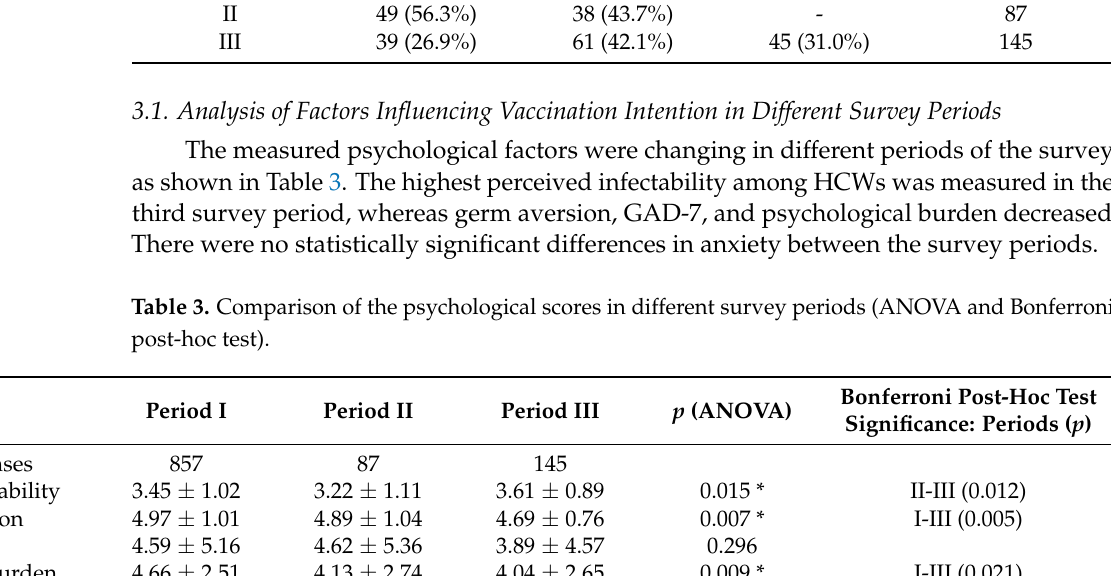
Table 2. Vaccination intention and vaccination status of the respondents in different survey periods. Vaccination Vaccination Already Intention Intention Not Survey Vaccinated Declared Declared Period N (%) N (%) N (%) I 526 (61.4%) 331 (38.6%) - 857 II 49 (56.3%) 38 (43.7%)